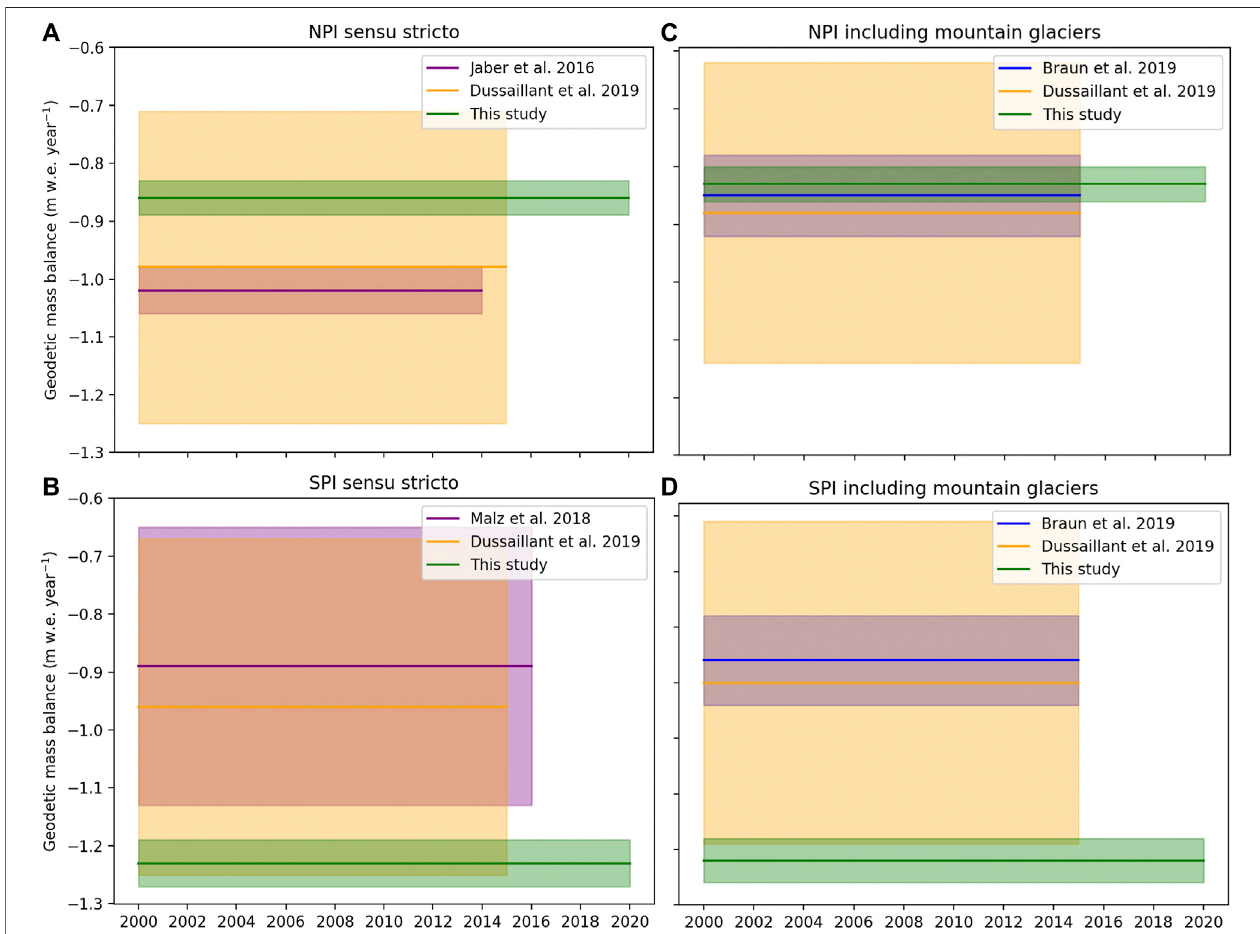
FIGURE 9 | Our regional area-weighted geodetic mass balance estimates for the ice fi elds sensu stricto (A,B) and the ice fi elds plus surrounding mountain glaciers (C,D) compared to other recent studies.